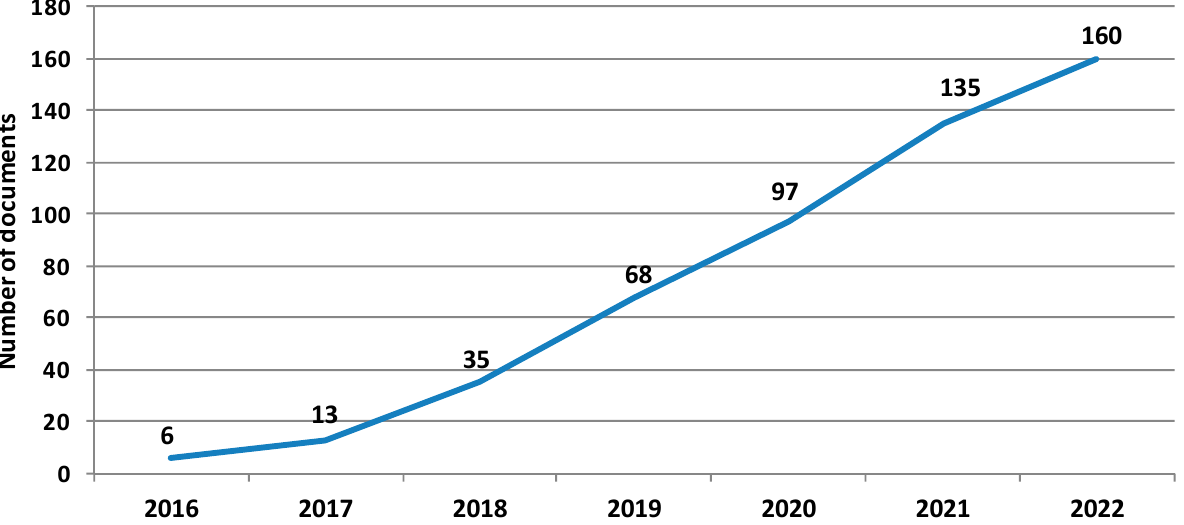
Figure 2. Evolution of the scientific production covering the bibliographic data collection: cumulative data from 2016 to 2022.